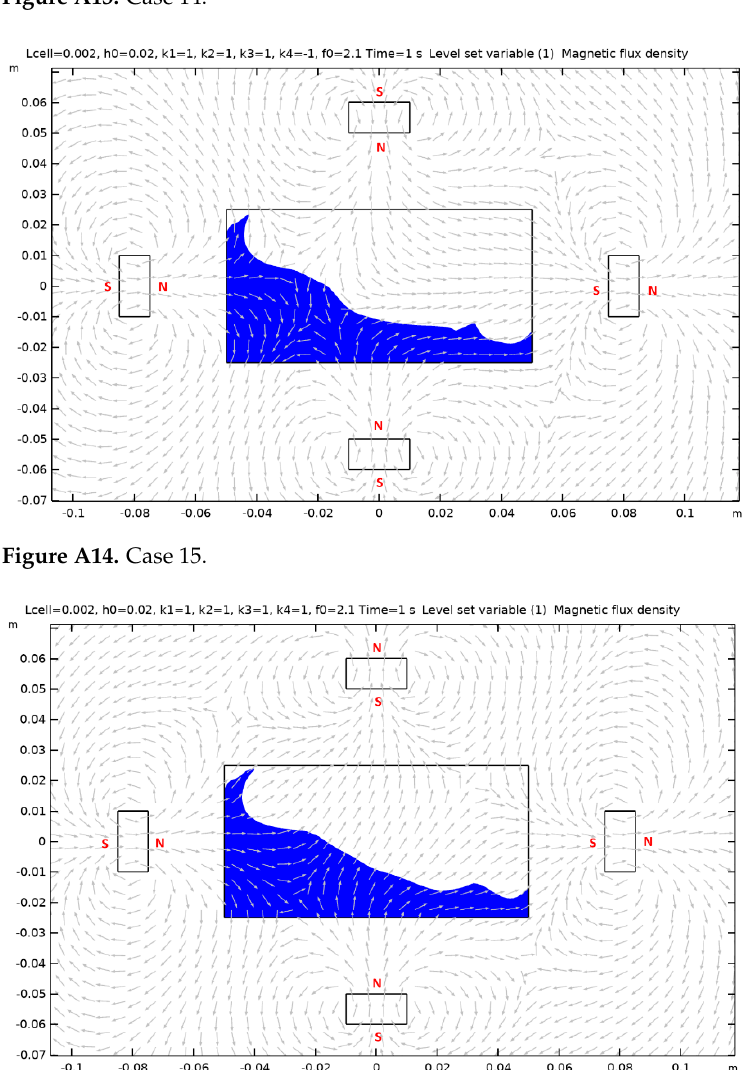
Figure A13. Case 14.